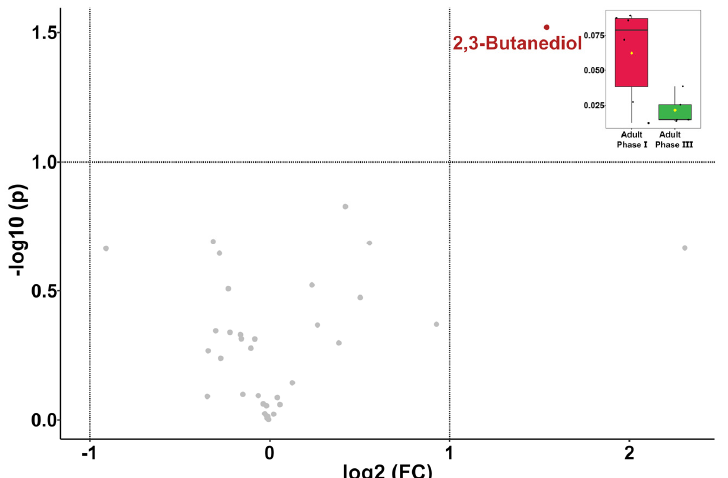
Figure 5. Volcano plot showing the differences in the concentrations of molecules in giant panda seminal plasma from adult phase I and III, studied by t -test. The boxplot in the right upper part shows 2,3-butanediol concentrations for each age group.